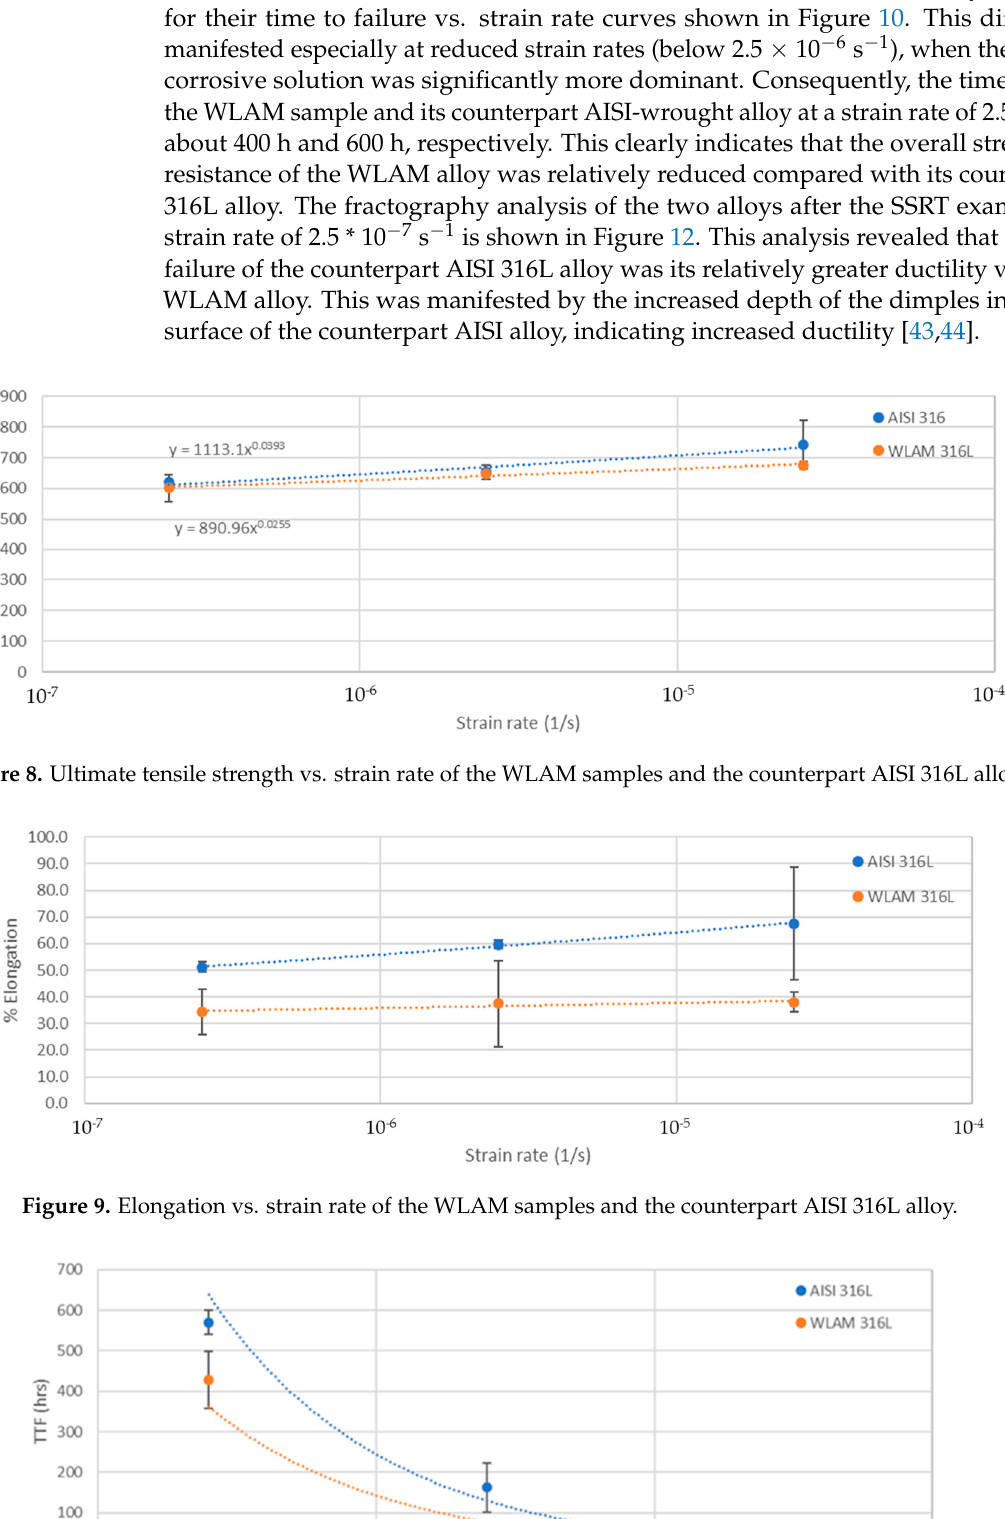
Figure 10. Time to failure vs. strain rate of the WLAM samples and the counterpart AISI 316L alloy.